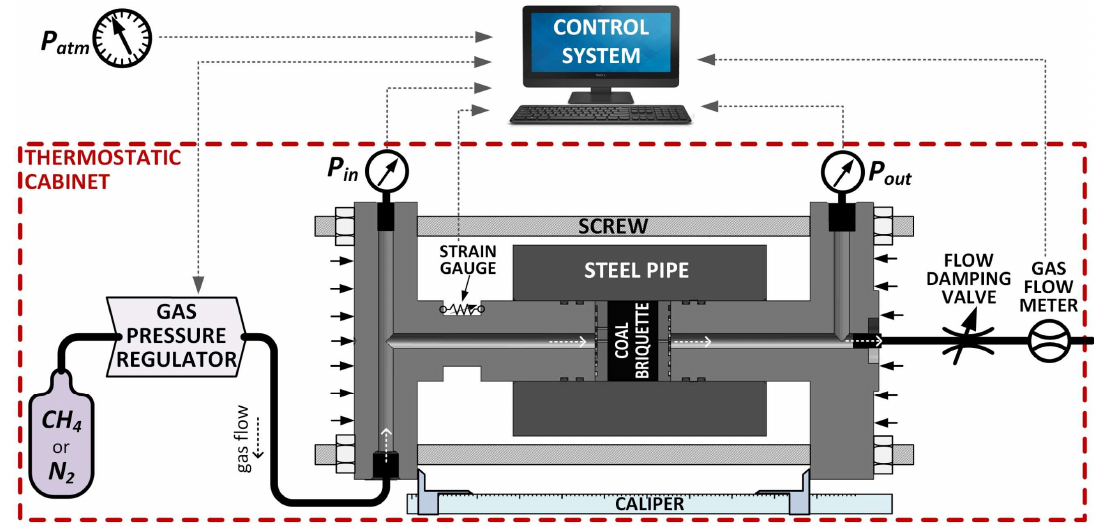
Figure 3. A scheme of the measurement stands for investigating coal permeability under stress conditions, where P in , P out —are the gas inlet and outlet pressure transducers; P atm —is the barometer.